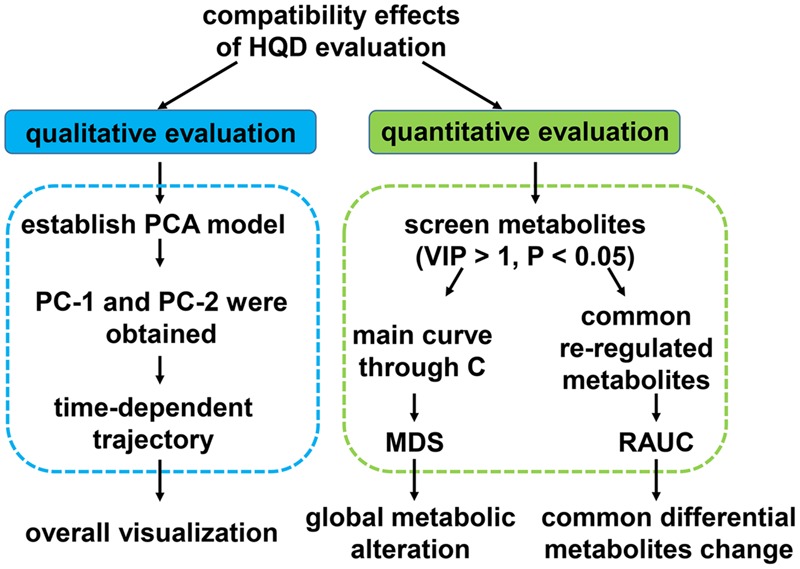
Scheme of compatibility effects evaluation.